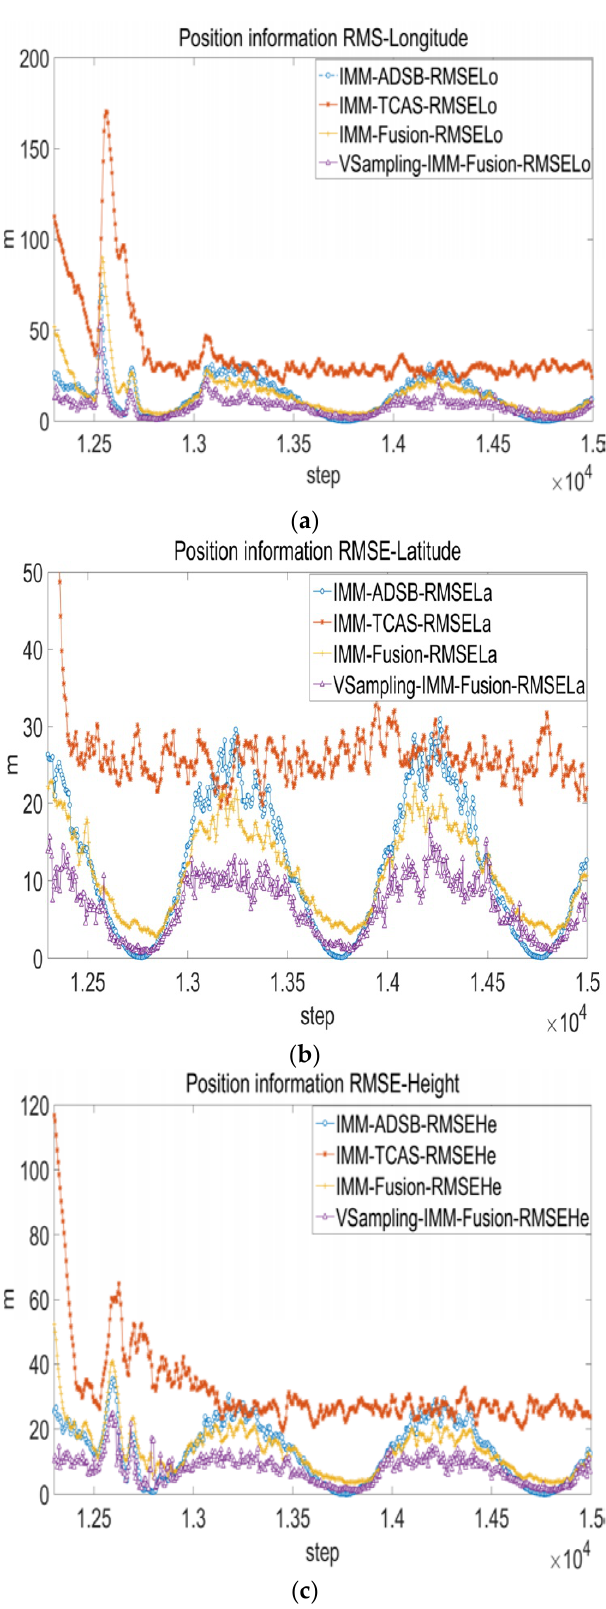
Figure 10. Root mean squared error of statistics. ( a ) Root mean squared error-Longitude; ( b ) Root mean squared error-Latitude; ( c ) Root mean squared error-Height.